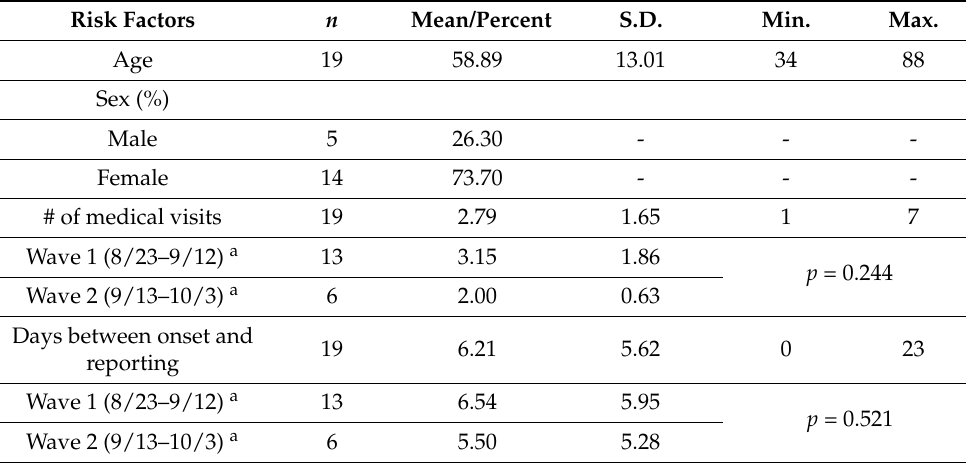
Table 1. Demographic features of confirmed cases and their medical visits.